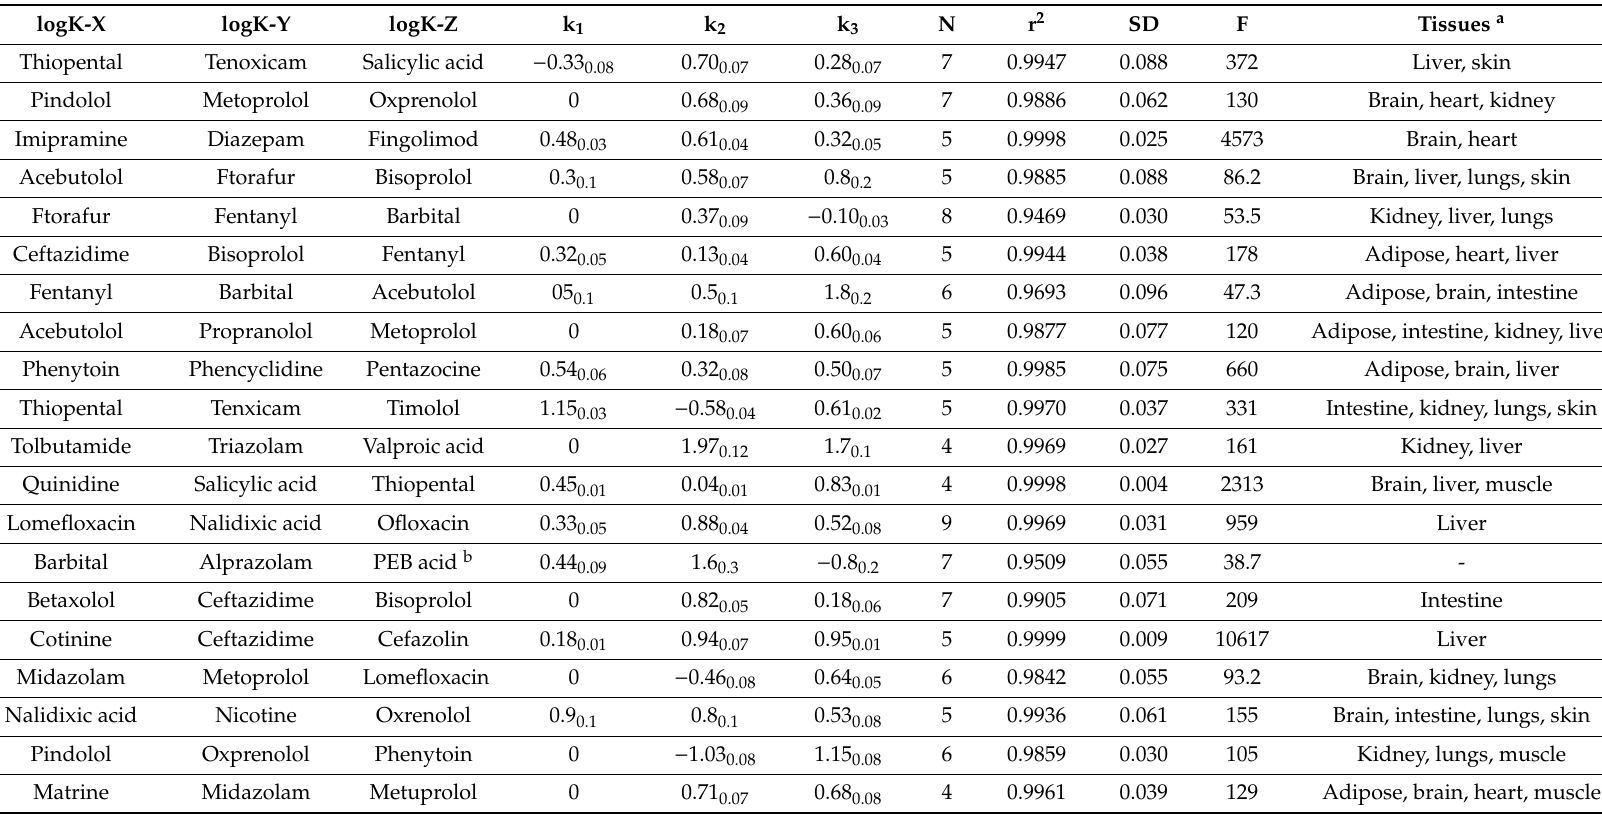
Table 4. Coe ffi cients and statistical characteristics of linear relationships (Equation (1)) between logarithms of partition coe ffi cients for various drugs between blood and di ff erent tissues * in rats in vivo (data from [22], see Table